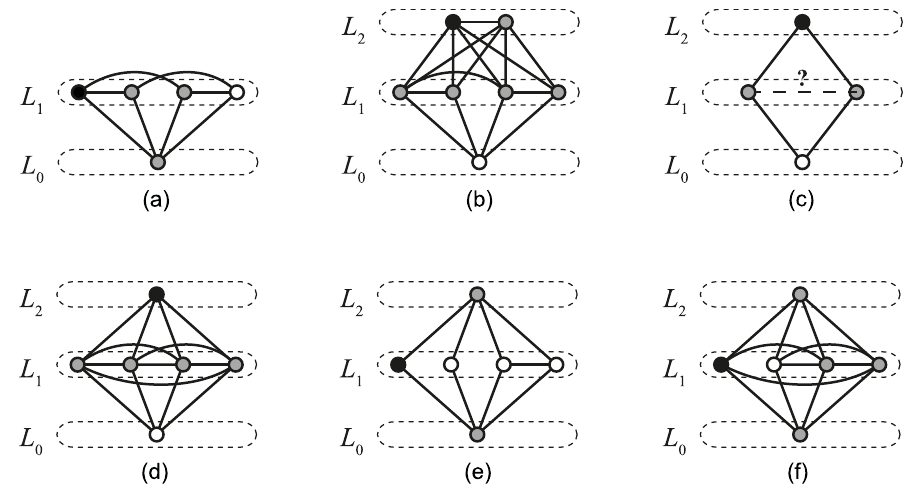
Fig 7. Illustrations of different cases. Node at the bottom level L 0 represents node x . The selectednode y is colored black and its neighboursare indicatedwith a gray color. (a) u = 1. (b) u = 2 ^ | L 2 | > 1. (c) u = 2 ^ | L 2 | = 1 ^ k = 4. (d) u = 2 ^ | L 2 | = 1 ^ k (cid:21) 5 ^ d ( l 1 ) = k − 1. (e) u = 2 ^ | L 2 | = 1 ^ k (cid:21) 5 ^ d ( l 1 ) < k − 2. (f) u = 2 ^ | L 2 | = 1 ^ k (cid:21) 5 ^ d ( l 1 ) = k −